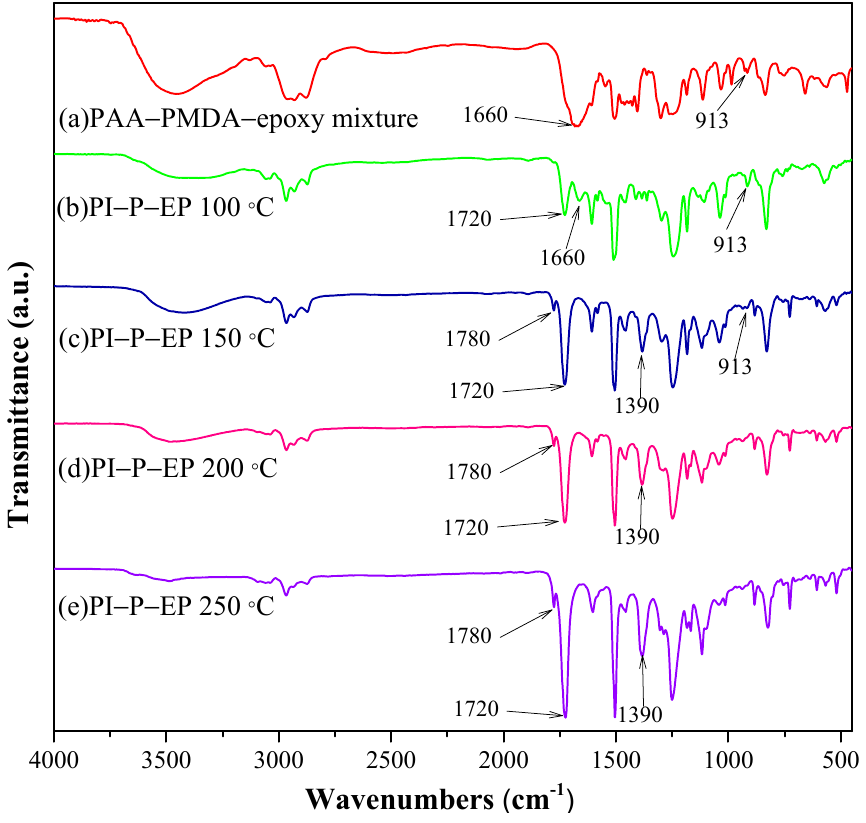
Figure 5. FTIR of the curing profile of PI(50)-P-EP(50) at different temperatures: ( a ) room tempera- ture ( b ) 100 °C, ( c ) 150 °C, ( d ) 200 °C, and ( e ) 250 °C. ( b ) 100 ◦ C, ( c ) 150 ◦ C, ( d ) 200 ◦ C, and ( e ) 250 ◦